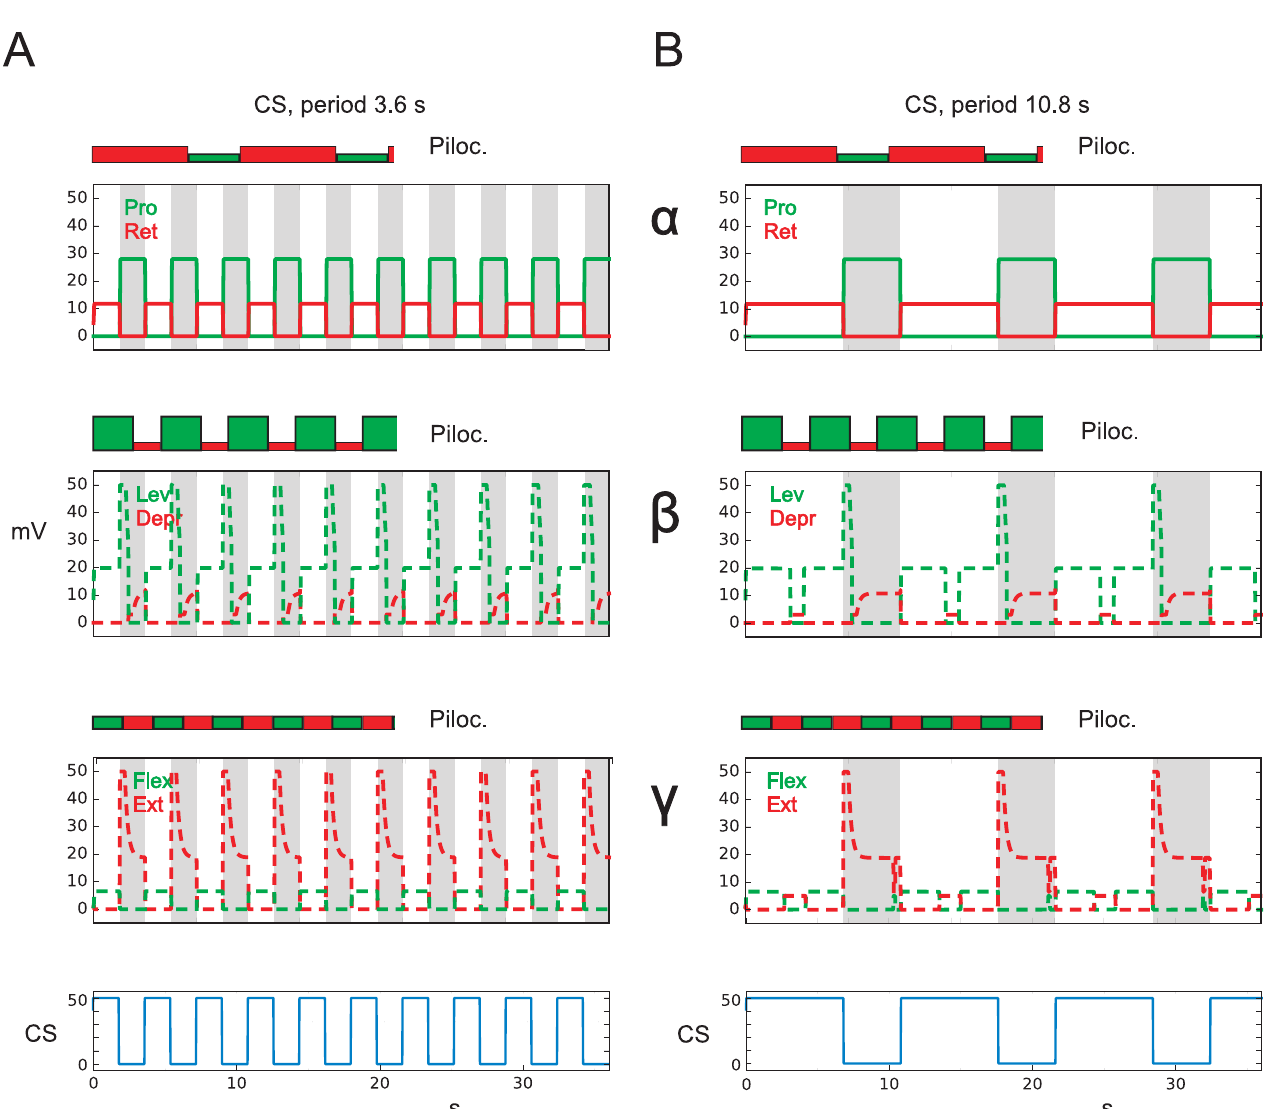
Fig 6. CS stimulus drives (via caudal bending of femur) protractor or retractor as observed in Akay et al. [20]. Cycles that are driven only by pilocarpine are plotted for each joint on top of the CS-driven results (same scale, periods: alpha joint: 10.2 s, beta joint 4.6 s, gamma joint: 4.2 s) and marked by the same colors but with filled rectangles and ‘Piloc.’. A) Sensory input, period: 3.6 s, B) Sensory input, period: 10.8 s. Abscissa: time (s), ordinate (mV). Dashed lines: simulation data for which no biological results are given.